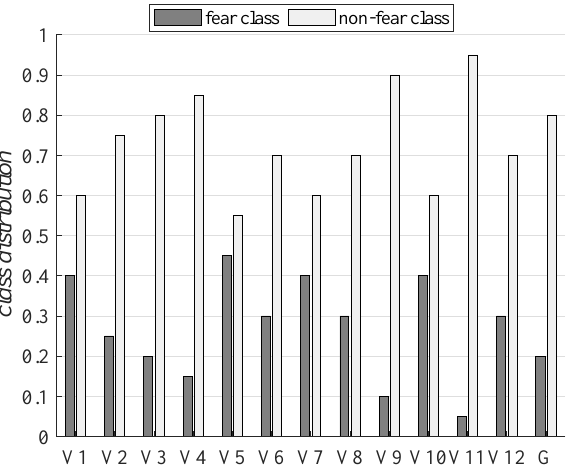
Figure 2. Subject-dependent class distribution for binary fear mapping over the subjective self-reports in MANHOB, and the original intended class distribution of the